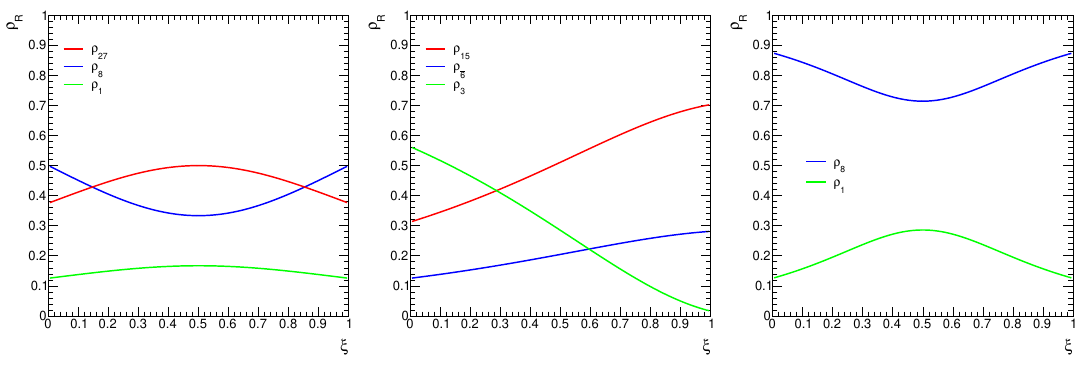
gg (left), qg qg (middle), ! ! qg !